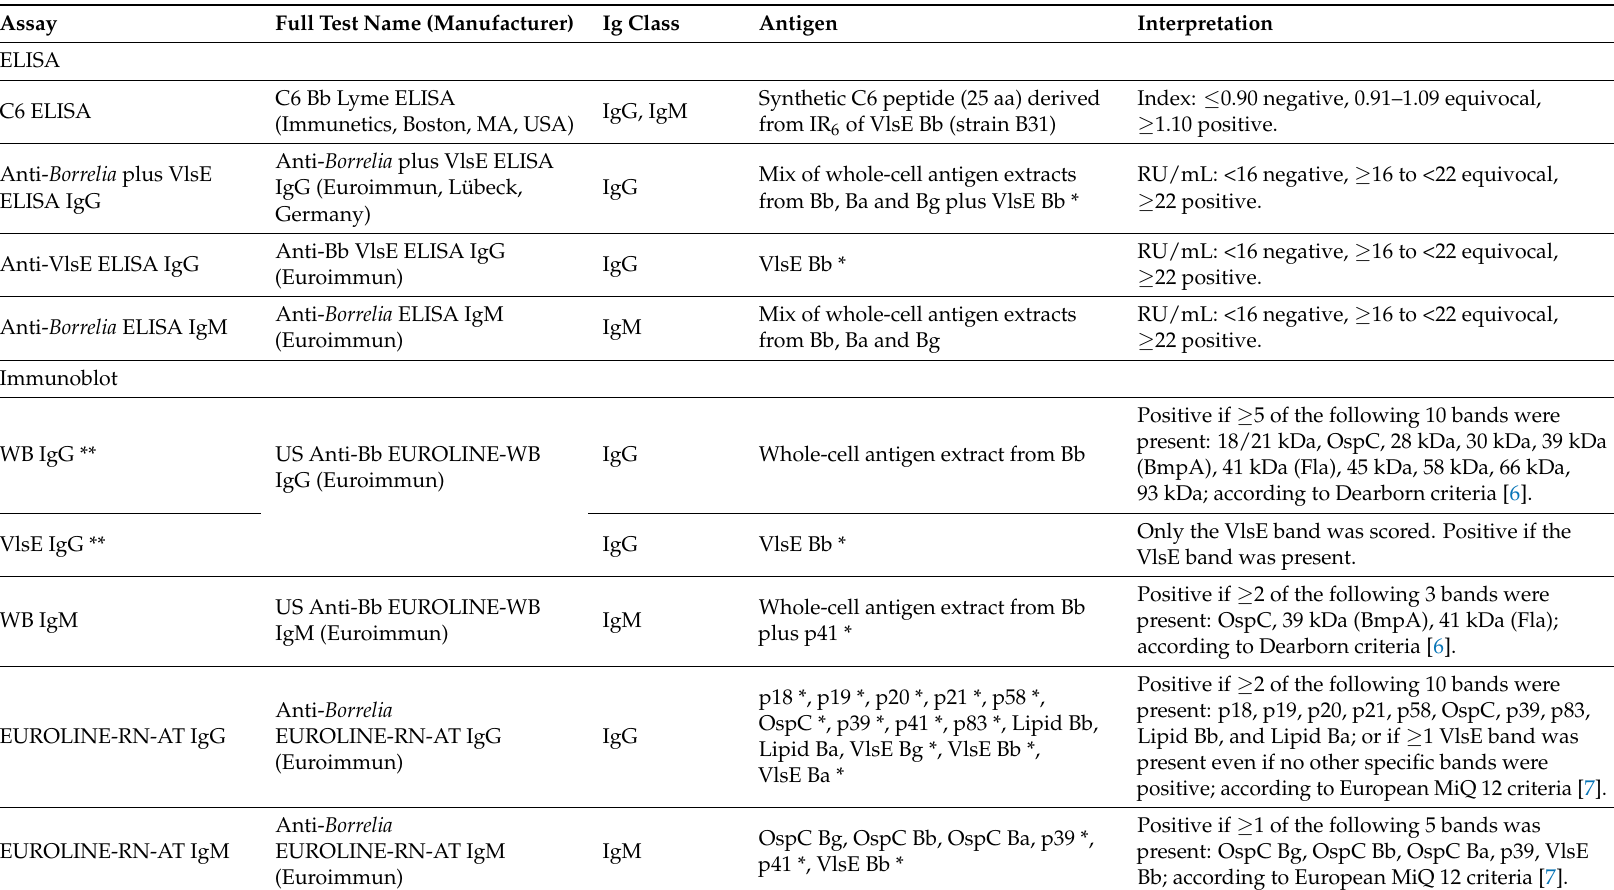
Table 2. Diagnostic assays evaluated in community screening survey, July